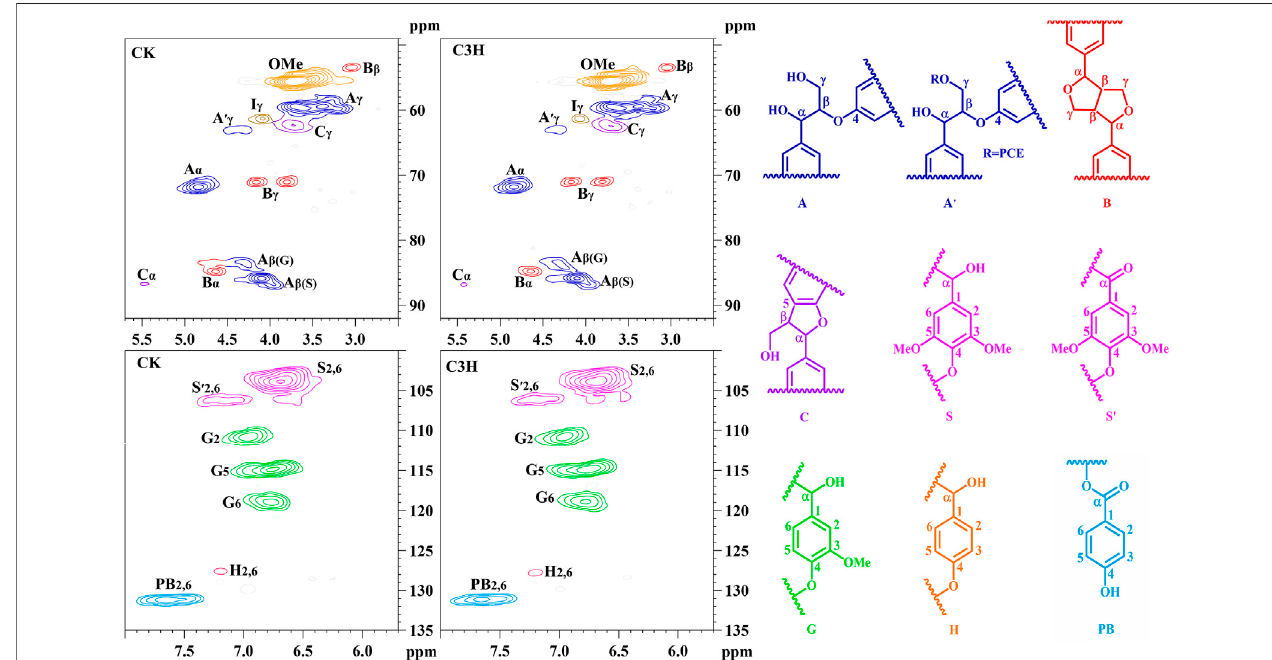
FIGURE 4 | 2D-HSQC spectra and identi fi ed main structures of the lignin fractions isolated from poplar wood.